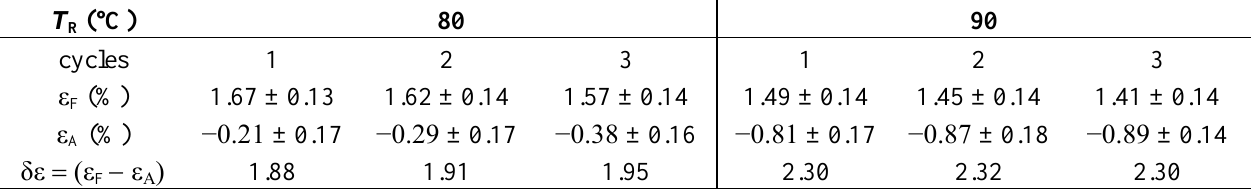
Table 2. Recovery activations and corresponding recovery fixities after heating (at 80